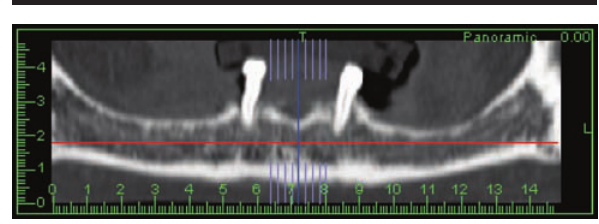
FIGURE 1 – Mandible axial section made in the Dental Slice software